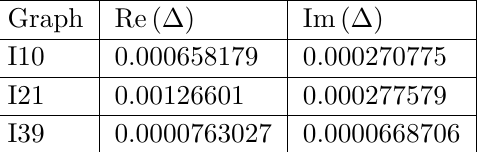
; 36 m 2 ] = [119716 ; 1077444] GeV 2 for I10 and I21 and 1 1